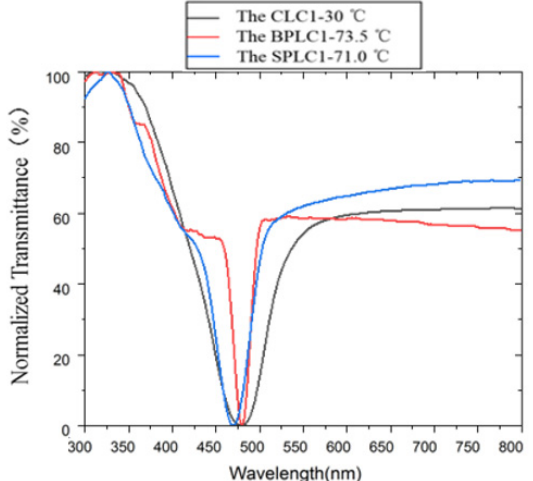
Figure 10. The reflection spectra of CLC1, BPLC1, and SPLC1.